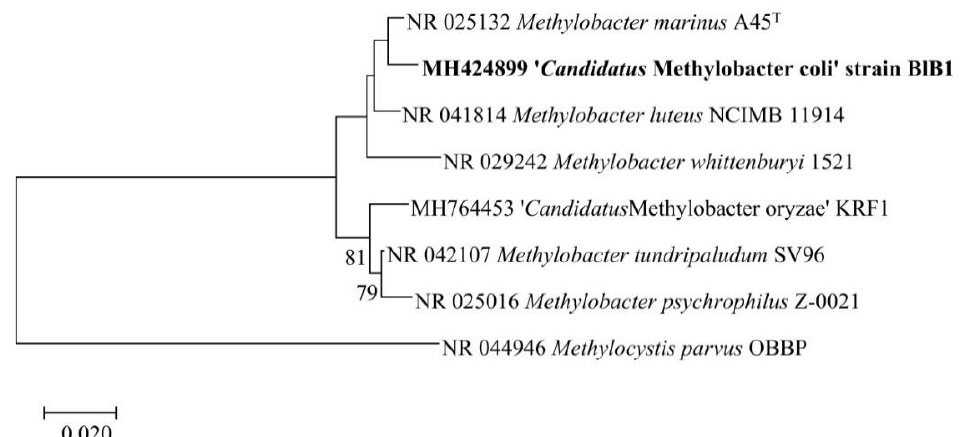
Figure 2. Maximum likelihood bootstrap tree of the 16S rRNA gene sequence of strain BlB1 in comparison with the 16S rRNA genes of closest valid species. The evolutionary history was inferred by using the maximum likelihood method and Tamura-Nei model and 1000 bootstraps (values >50 shown). The bar represents 2% divergence. The phylogenetic tree was constructed using MEGA X.